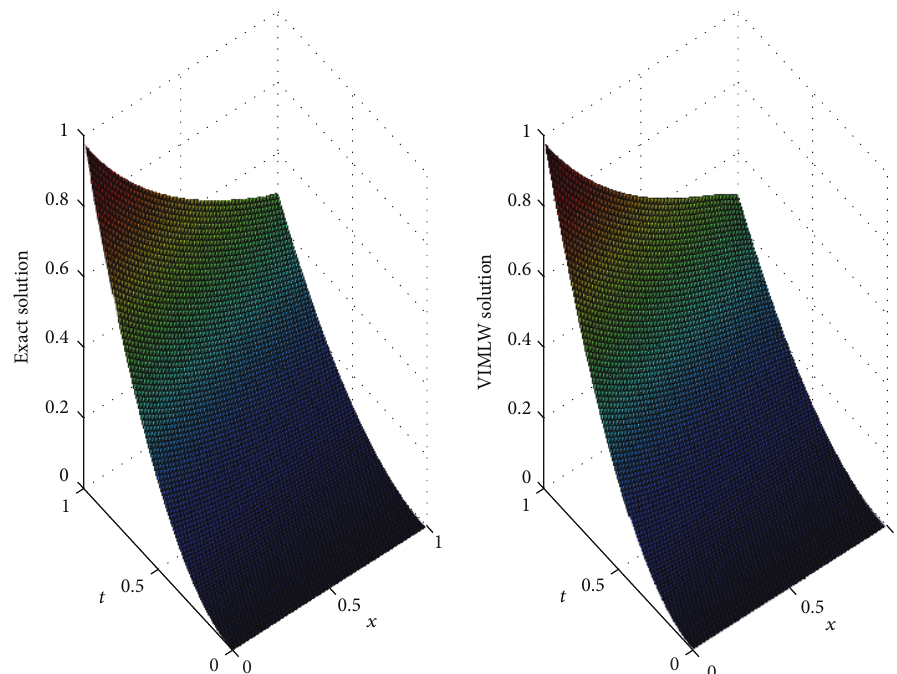
Figure 2: Exact solution and VIMLW approximate solution of Example 5.